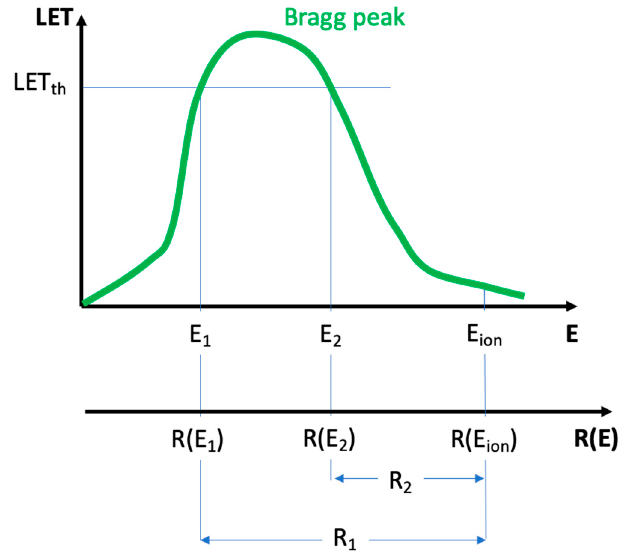
Figure 3. Illustration of the relationship between the threshold LET and the range of the particle.